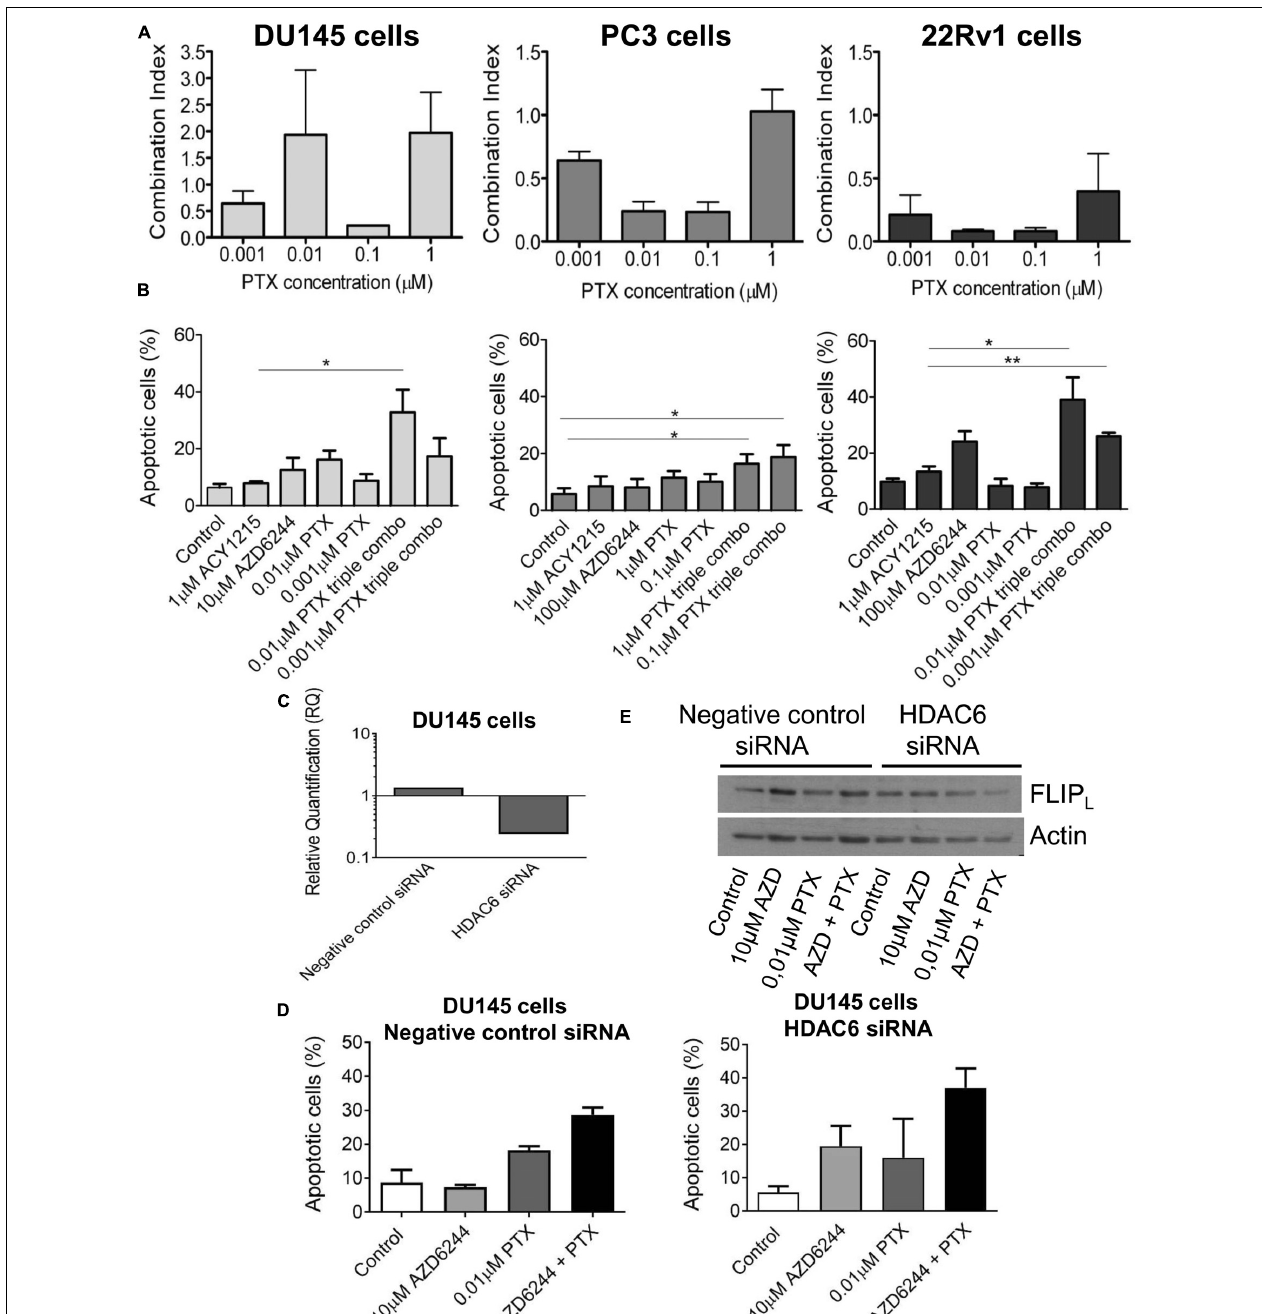
FIGURE 4 | Analysis of the drug interaction and apoptotic response in prostate carcinoma cells simultaneously treated with the MEK inhibitor AZD6244, the HDAC inhibitor ACY1215 and paclitaxel. Cell sensitivity to increasing concentrations of selumetinib (AZD6244), ricolinostat (ACY1215) and paclitaxel (PTX) or to their combination was assessed by growth inhibition assays in DU145, PC3 and 22Rv1 cells. Cells were exposed for 72 h to each drug alone or to the drug combination with 1 µ M ACY1215 (for all cell lines) and 10 µ M AZD6244 (for DU145 cells) or 100 µ M AZD6244 (for PC3 and 22Rv1 cells). Histograms of the mean of Combination Index (CI) values of at least 3 independent experiments are shown (A) . Cells were exposed to single agents or to their combination and harvested 48 h after treatment start for analysis of apoptosis by Annexin V binding assay; P < 0.05 by t test (B) . Knockdown of HDAC6 by siRNA transfection in DU145 cells. qRT-PCR analysis of HDAC6 mRNA levels at 72 h after transfection start; untrasfected cells were used as calibrator and GAPDH as housekeeping gene (C) . Analysis of apoptosis in transfected cells exposed to MEK inhibitor AZD6244 and PTX or to their combination (72 h). At the end of treatment cells were harvested for analysis of apoptosis by Annexin V binding assay (D) . Western blot was carried out in DU145 transfected cells incubated with AZD6244 and PTX or their combination (72 h). Control loading is shown by actin. The protein band intensity was quantified using ImageJ, normalized to that of the loading control and expressed relative to the level of control cells (set to 1). Normalized values of FLIP L corresponding to 10 µ M AZD6244, 0.01 µ M PTX, 10 µ M AZD6244 plus 0.01 µ M PTX, were 1.52, 1.34, 1.19 for negative control siRNA; 1.15, 1.35, 0.63 for HDAC6 siRNA, respectively (E) .